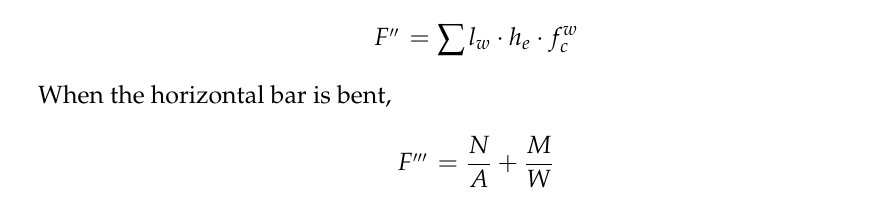
Figure 9. Bending failure mode of a horizontal bar.